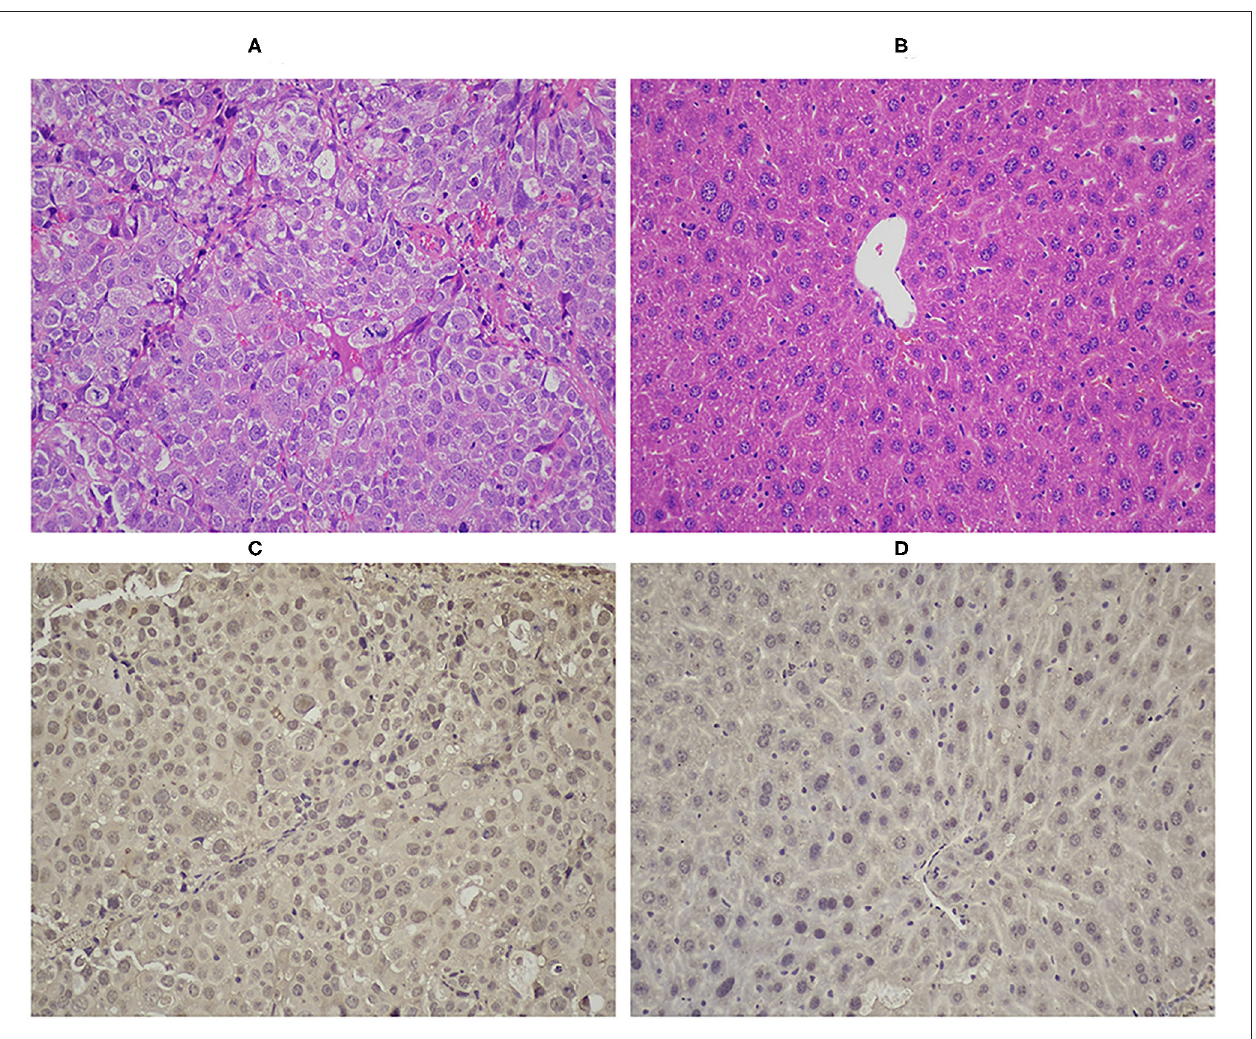
FIGURE 6 | HandE staining of tumor ( A , × 200) and of healthy liver ( B , × 200). Immunohistochemical staining of EAAC1 in tumor ( C , × 200) and in normal liver tissue ( D , × 200). EAAC1, excitatory amino acid carrier 1; HandE, hematoxylin and